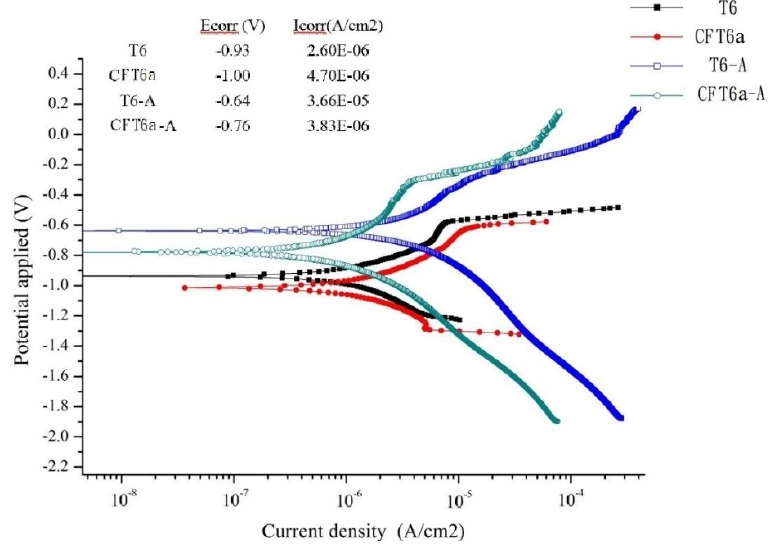
Figure 10. Polarization curves obtained from immersion tests of T6 and CFT6a samples with/without anodization/sealing treatment.